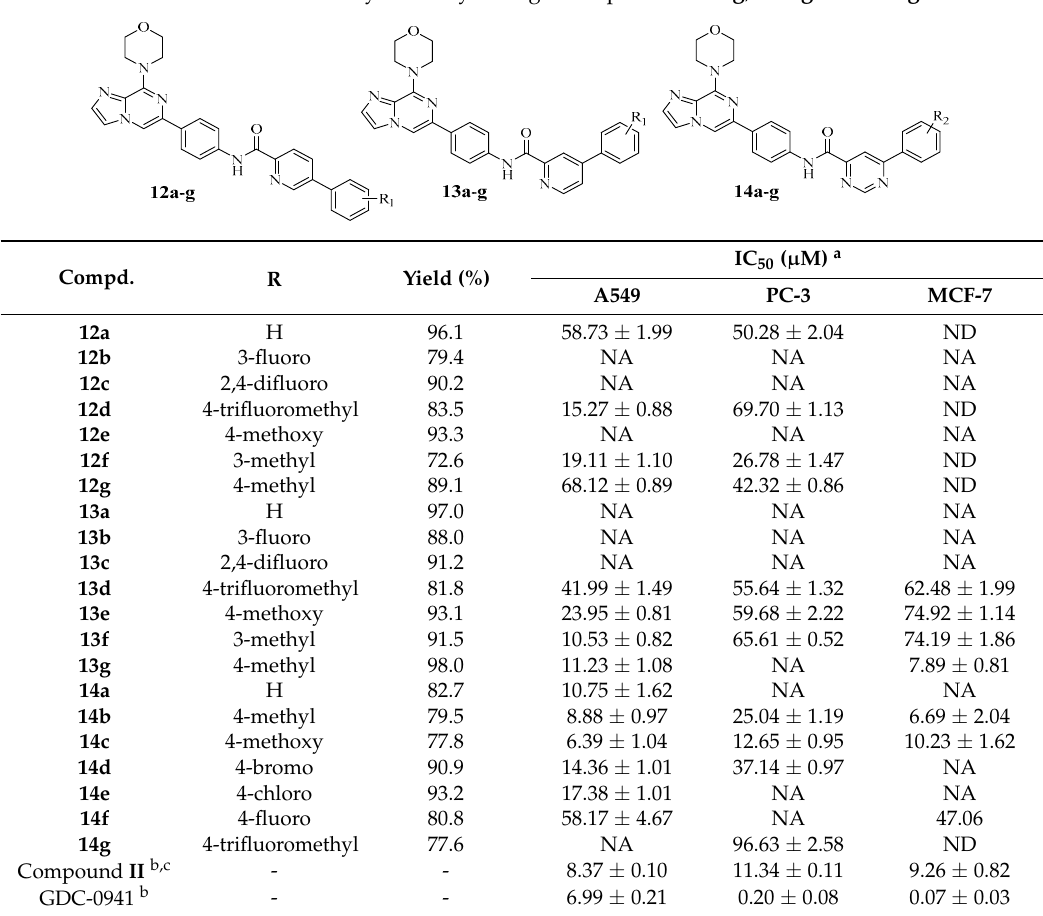
Table 1. Structures and cytotoxicity of target compounds 12a – g , 13a – g and 14a – g .